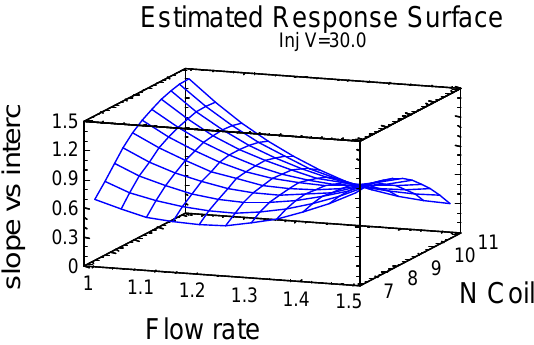
Figure 11. The estimated response surface for the slope versus intercept quotient (b/a) at the 30- m L injection volume of the colour-forming